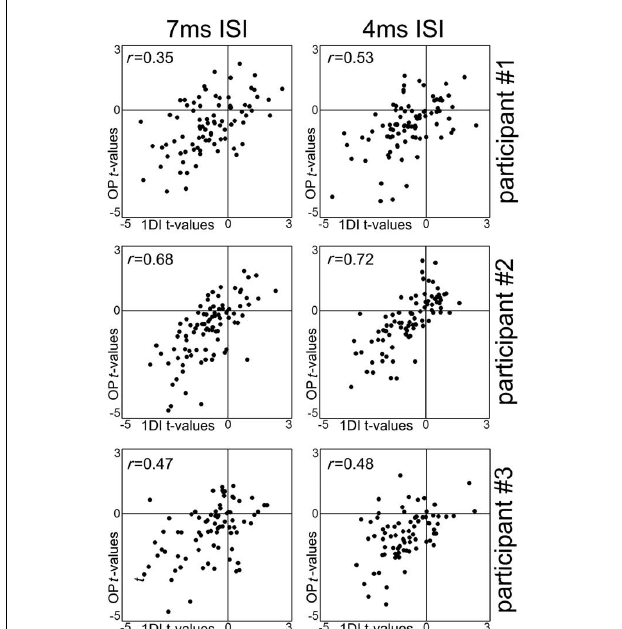
FIGURE 4 | Scatterplots of the t -values obtained for each spot with the samplings of the 1DI muscle alone plotted against the t -values obtained with the samplings of the OP muscle alone. Each dot represent data from a single spot of the scalp grid.The r -values refer to Pearson’s correlation test. All p -values are < 0.0001.